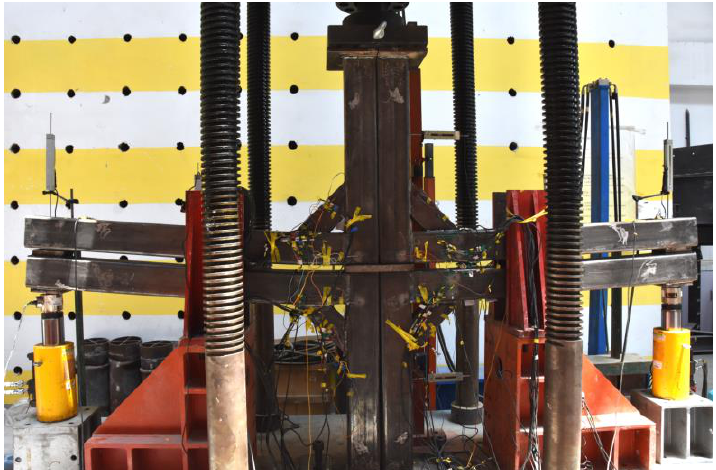
Figure 14. Loading procedure